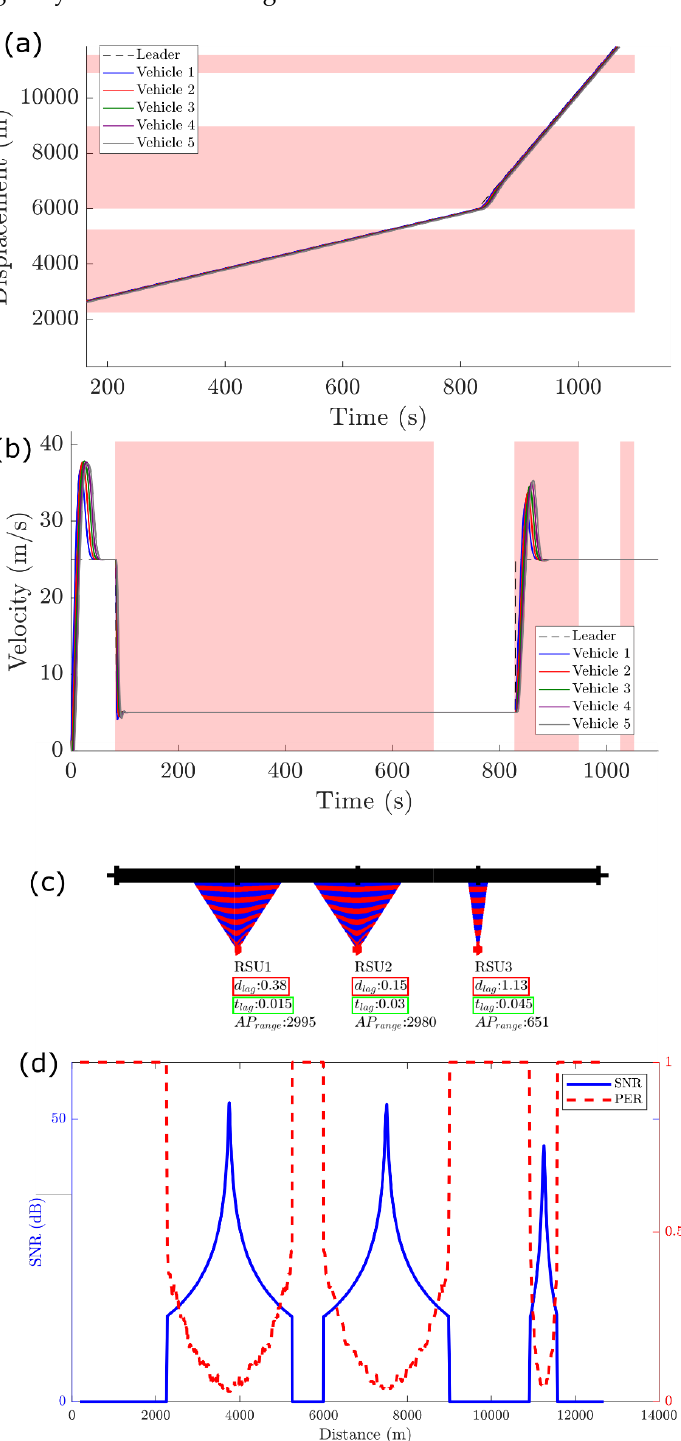
Figure 11. Case V vehicle platoon motion as described in Section 3.4: ( a ) Displacement of the vehicles over the simulation time; ( b ) Velocity of the vehicles over the simulation time; ( c ) Depiction of the coverage range of RSU’s (red) and the range during which the car communicates with the RSU (blue). The distance lag (red), time lag (green) and the RSU range are also mentioned; ( d ) Variation of SNR and PER as the platoon moves along the road. Leader is the platoon leader.